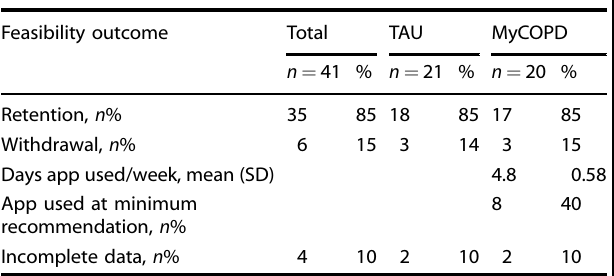
Table 2. Feasibility outcomes.